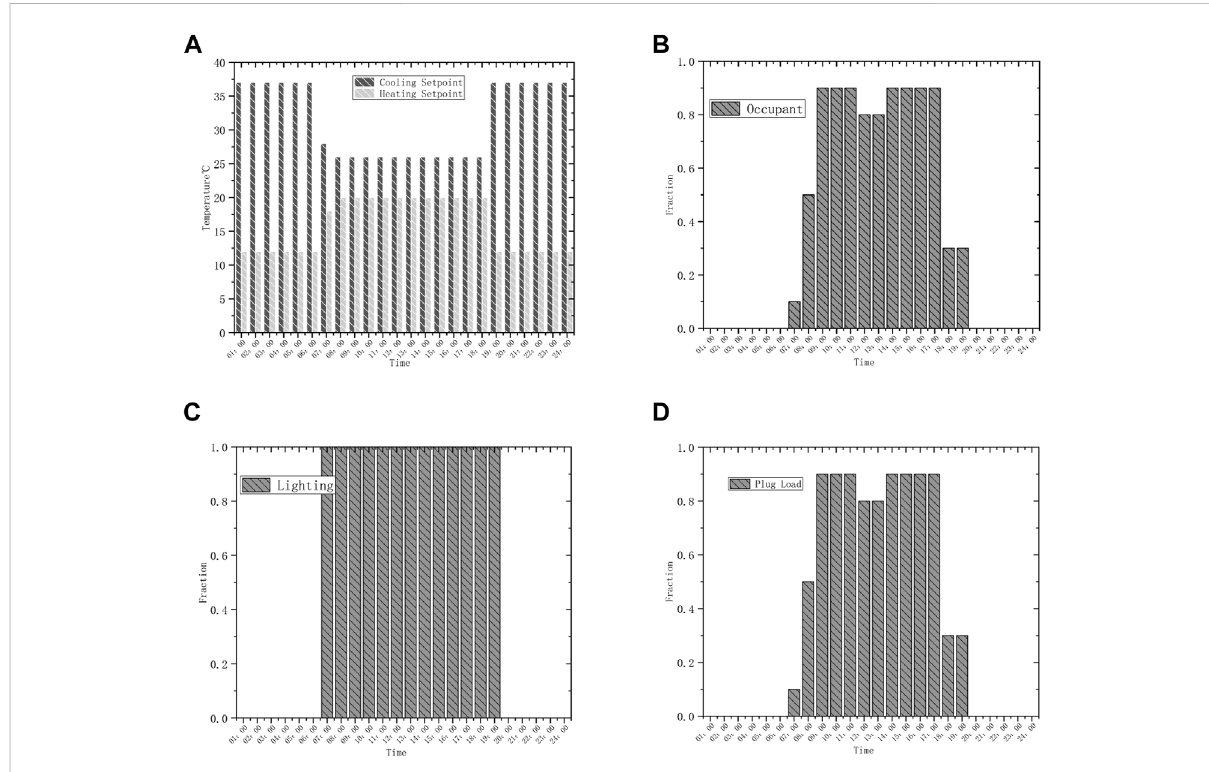
FIGURE 5 Energy simulation con fi guration. (A) Cooling and heating setpoint. (B) Occupant. (C) Lighting. (D) Plug load.